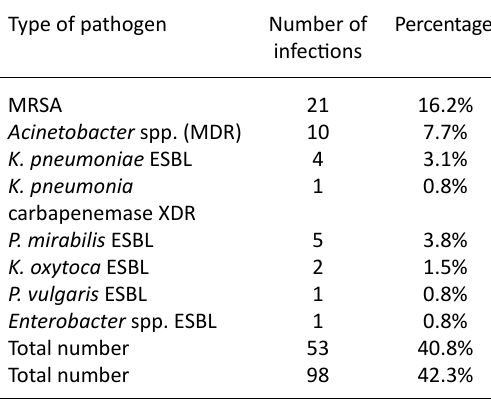
Table 4-B.2. High drug-resistant and MDR isolates of